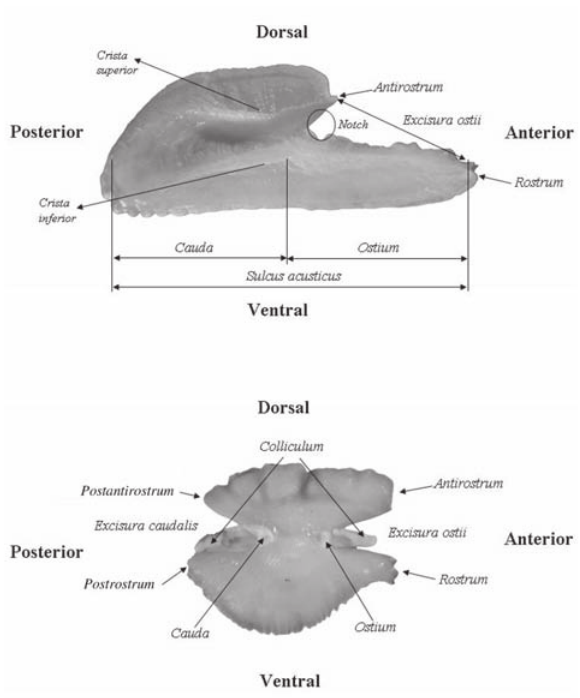
Fig. 3. – View of the mesial surface of the sagitta illustrating the most relevant